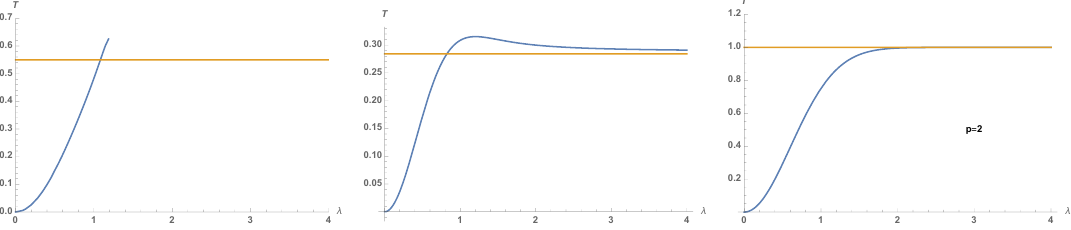
Figure 26 . Tachyon as a function of the Wilson line coupling constant, left in Siegel gauge, center for the TT/KOS solution, and right from the shifted 3-point function.